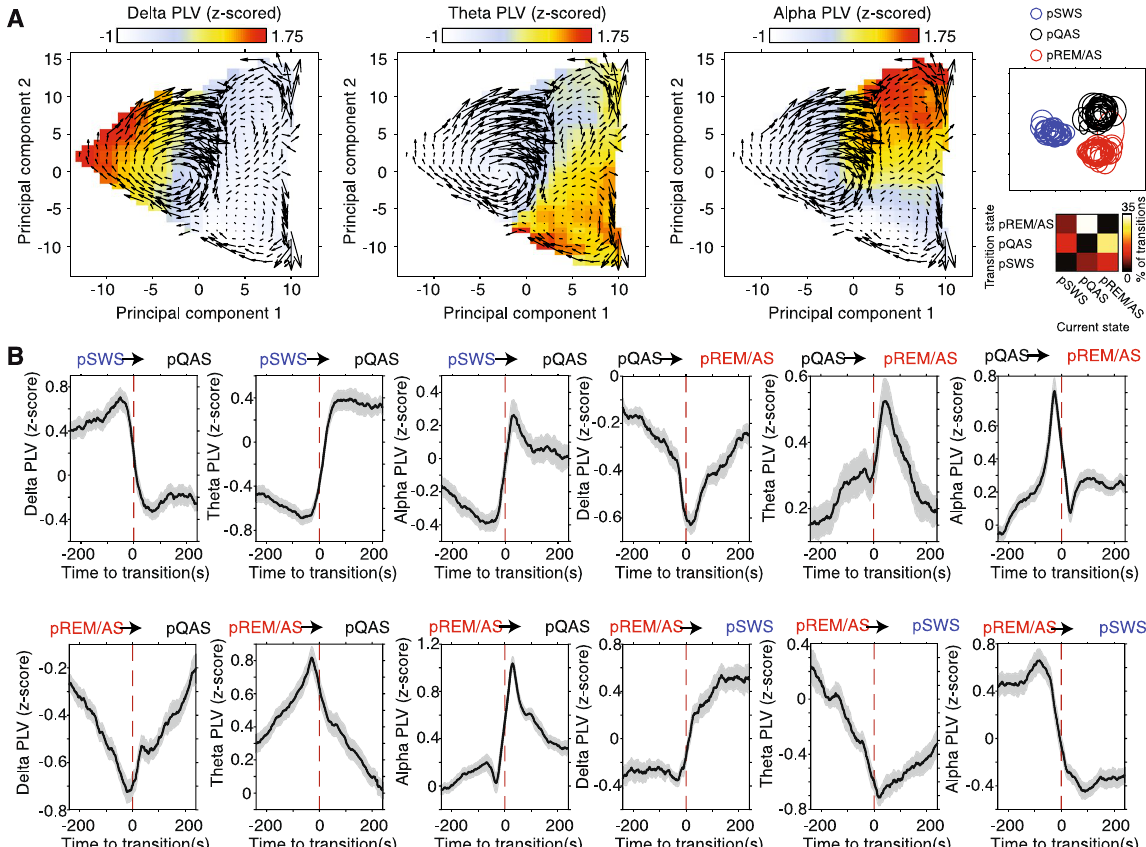
Figure 7. State-dependent fluctuations in cortical synchronization. ( A ) Population average PLV for delta (left), theta (middle), and alpha (right) frequency bands across the first two principal components of state space. In each plot population average state-space trajectories are overlaid to illustrate how animals transitioned between brain states. PLV’s were z-score normalized within session prior to computing mean PLV to account for differences in baseline connectivity between animals and sessions. The location of pSWS, pQAS, and pREM/ AS clusters in state space is shown in the upper right for reference, while the frequency of state transitions is shown in the bottom left. Note that each clustered brain state is predominantly characterized by cortical synchronization in a different carrier frequency band. In addition, elevated PLV’s in the theta band extend from the pREM/AS cluster into the pQAS cluster. ( B ) Mean ( ± SEM) z-score normalized PLV’s time-locked to the most frequent state transitions. The identity of brain state transition is indicated above each plot, while PLV carrier frequency is labeled on the y-axis. Note that most state transitions are marked by distinct fluctuations in cortical synchronization across each carrier frequency band. In addition, transitions between pQAS and pREM/ AS display more rapid reorganization of cortical synchronization than transitions to and from the pSWS